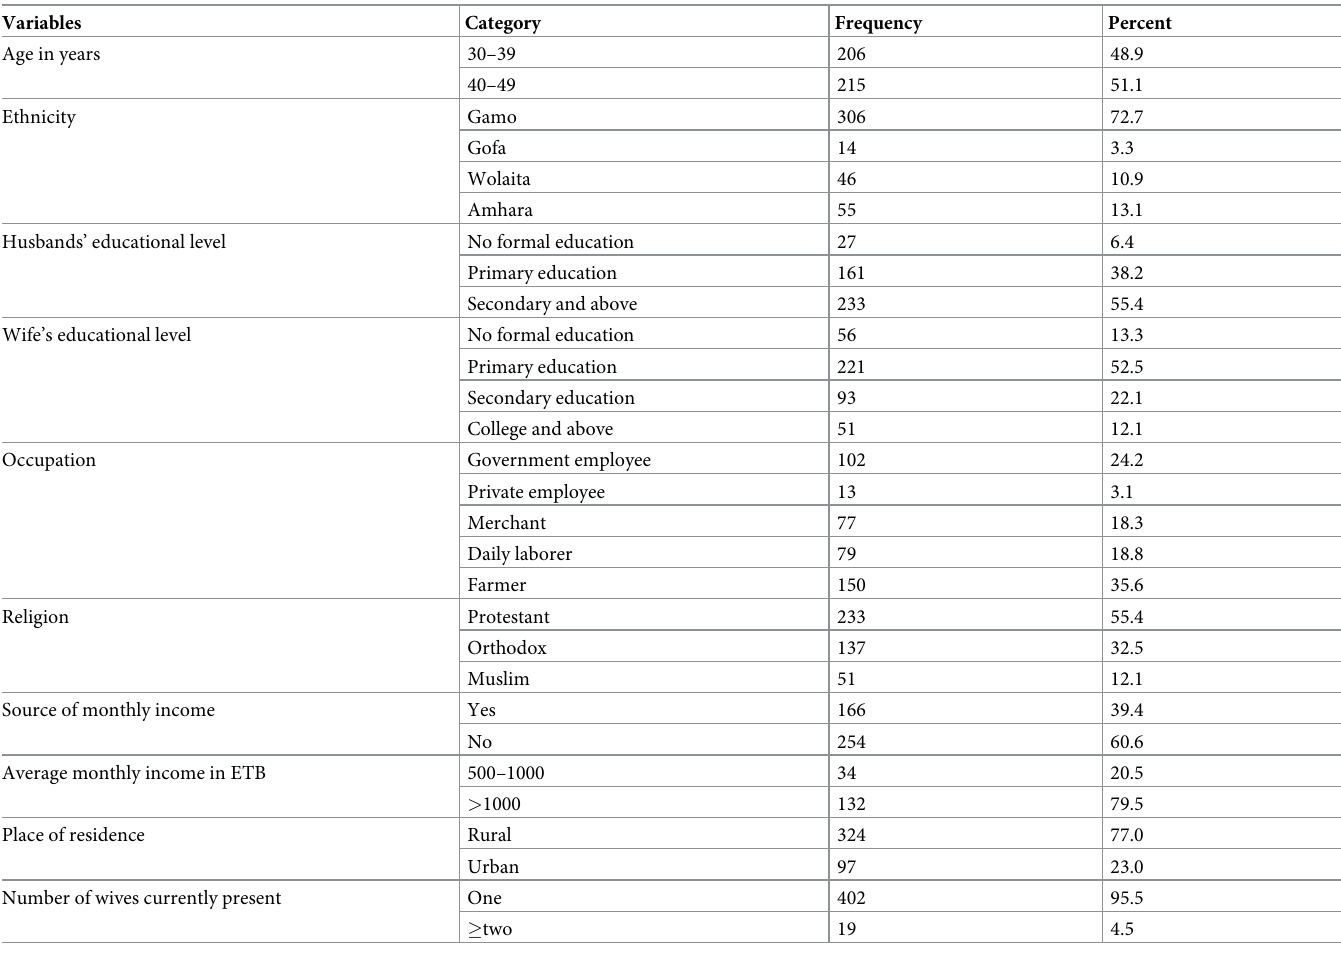
Table 1. Socio-demographic characteristics of respondents in Kucha district, Gamo zone, southern Ethiopia,